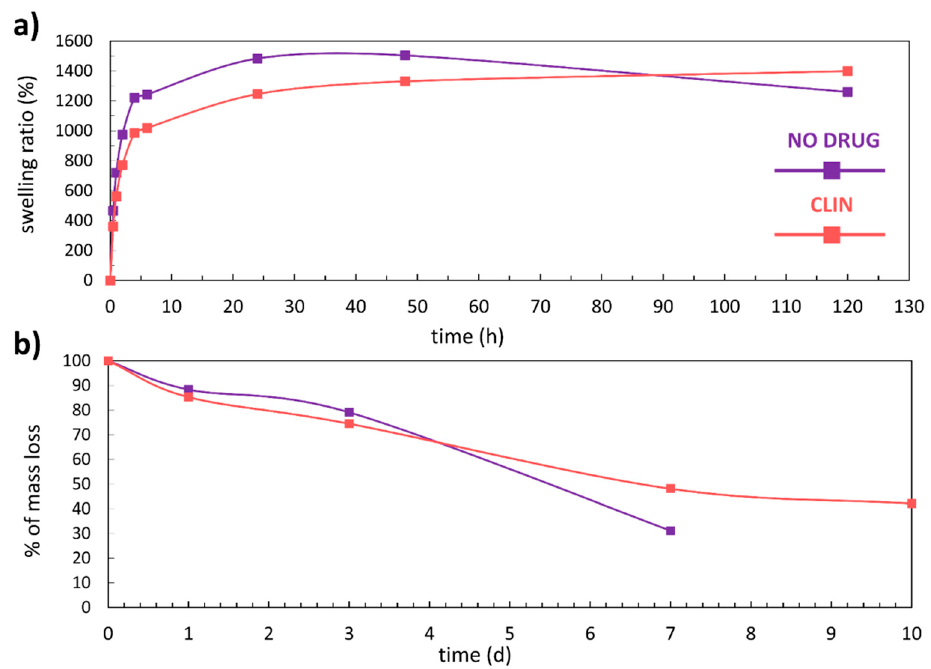
Figure 5. ( a ) Swelling kinetics of the 3D-printed coatings in phosphate - buffered saline (PBS) (pH 7.4) at 37 °C and ( b ) degradation curves (% of mass loss as a function of time) of the 3D-printed coatings in PBS (pH 7.4) at 37 °C.